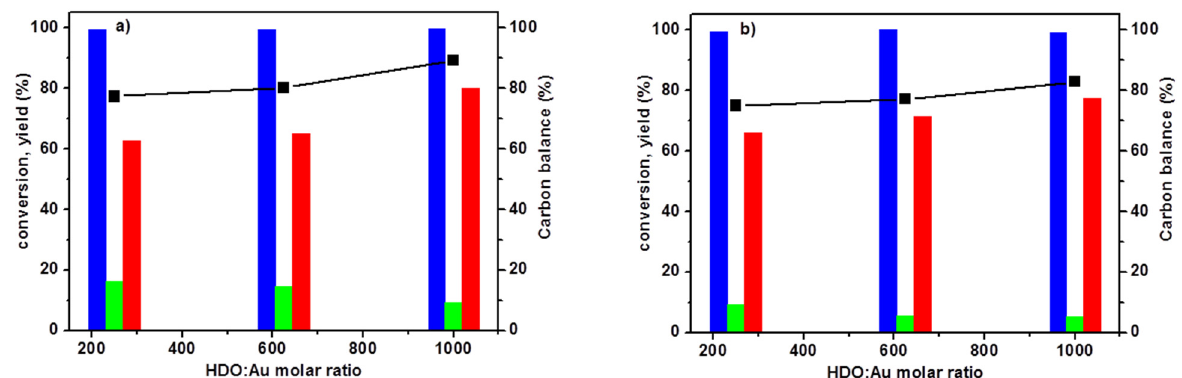
Figure 7. Effect of HDO/Au molar ratio on conversion and yield to products in the presence of ( a ) Au/AC_PVA and ( b ) Au/AC_PVP catalysts: ( ■ ) HDO conversion, ( ■ ) AA yield, ( ■ ) HHA Yield, ( ■ ) Carbon balance. Reaction conditions: HDO 42 mmol L − 1 , 20 mL H 2 O, 110 °C, 15 bar air, 800 rpm, 4 h, stabilizer/Au weight ratio of 1.2.